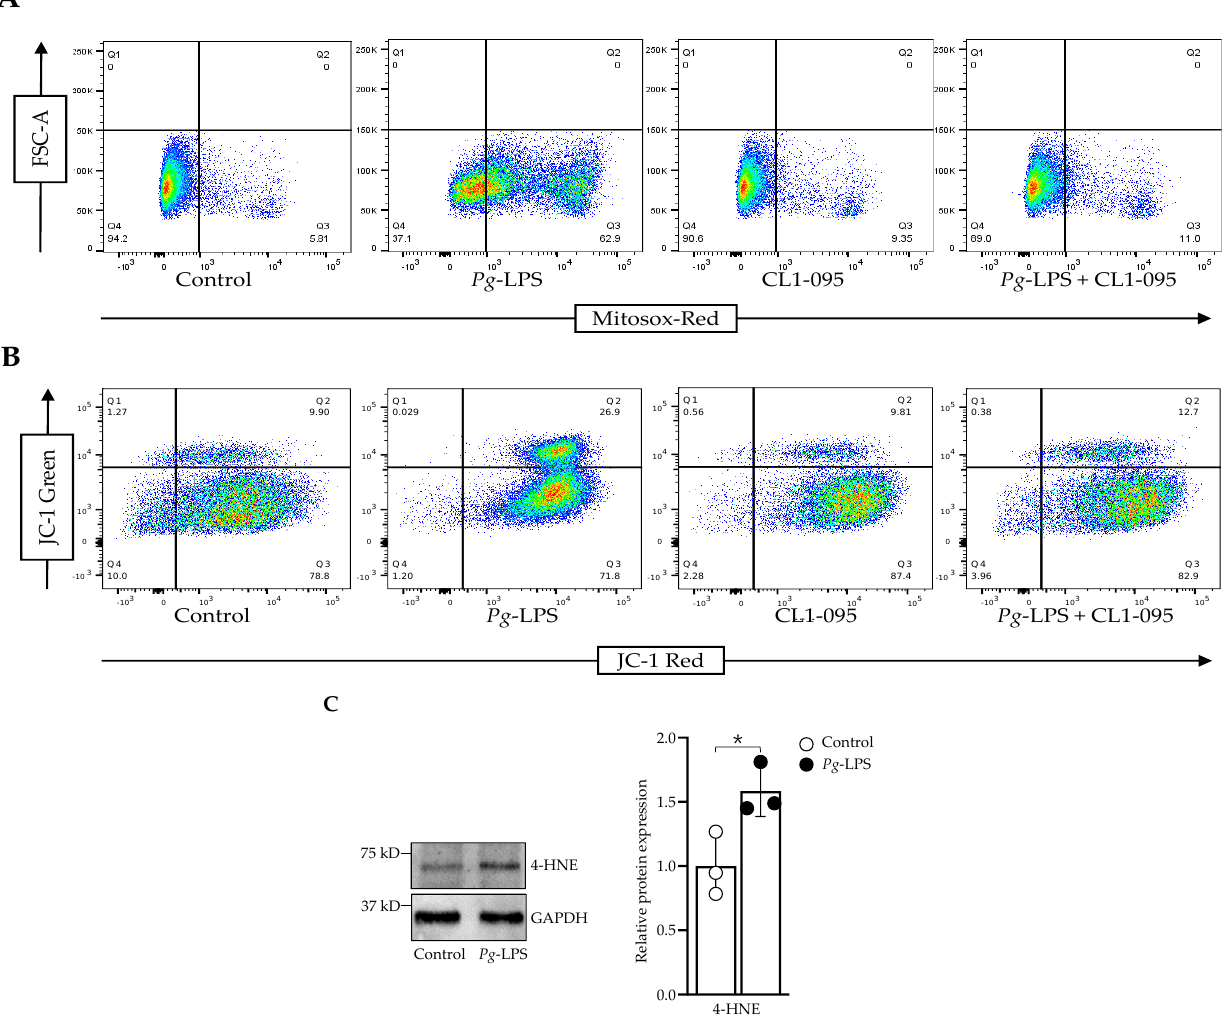
Figure 2. P. gingivalis -LPS induced oxidative stress and decreased membrane potential. ( A ) Cells were stained with MitoSOX Red, and ROS-producing cells were sorted using flow cytometry. ( B ) JC-1 staining was used to assess the decline in the membrane potential. ( C ) Western blot analysis of 4-HNE and GAPDH was used as a loading control ( n = 3). * p <